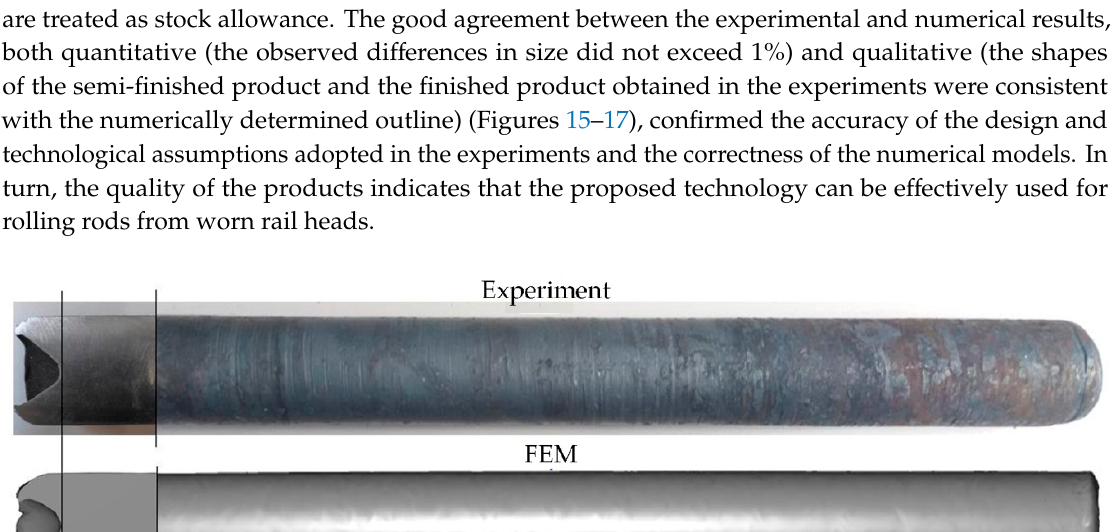
Table 3. Geometric parameters of rolled rods and preforms.